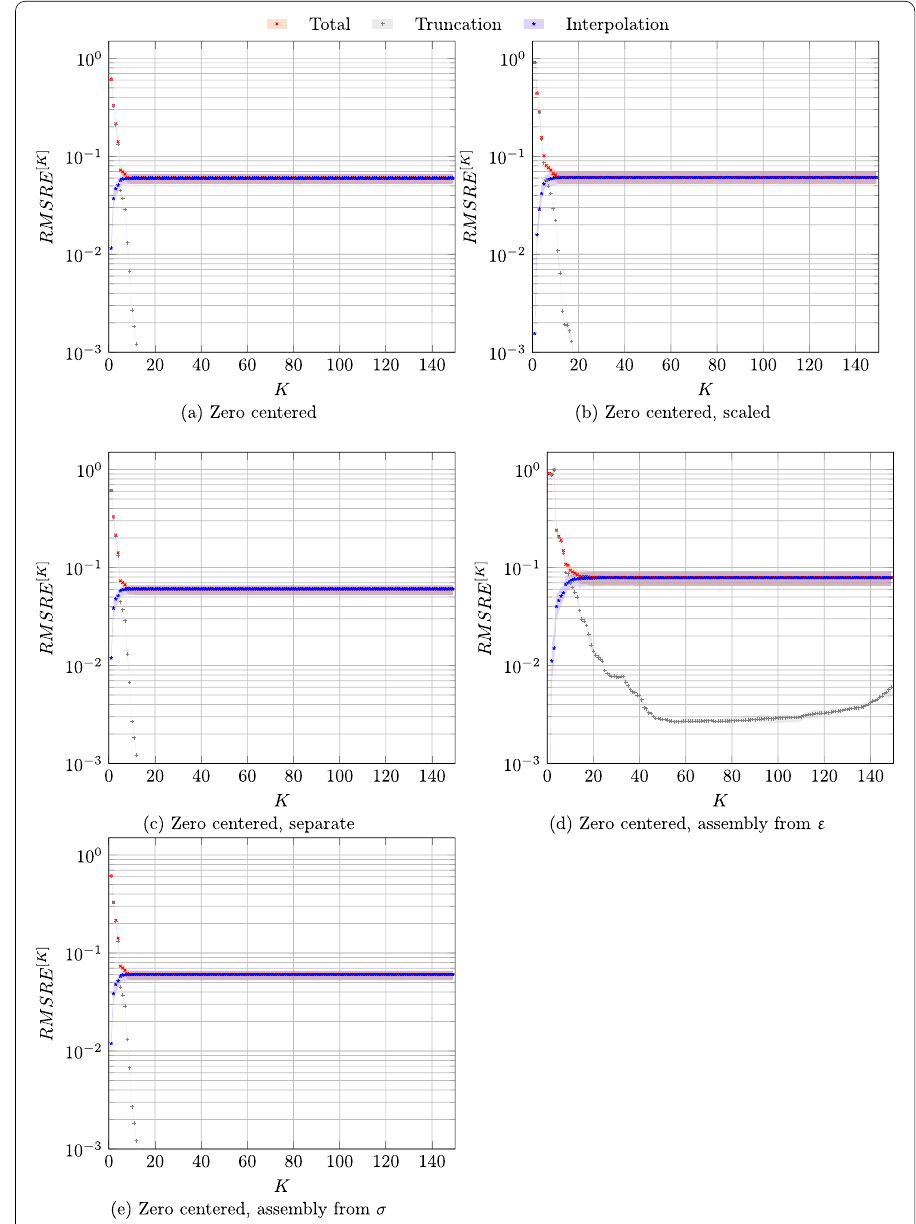
Fig. 9 RMSRE of the stress field of the pure bending problem using 5 different methods for surrogate model construction. The markers represents the mean over the 5 training sets. The shaded area represents the range over all training